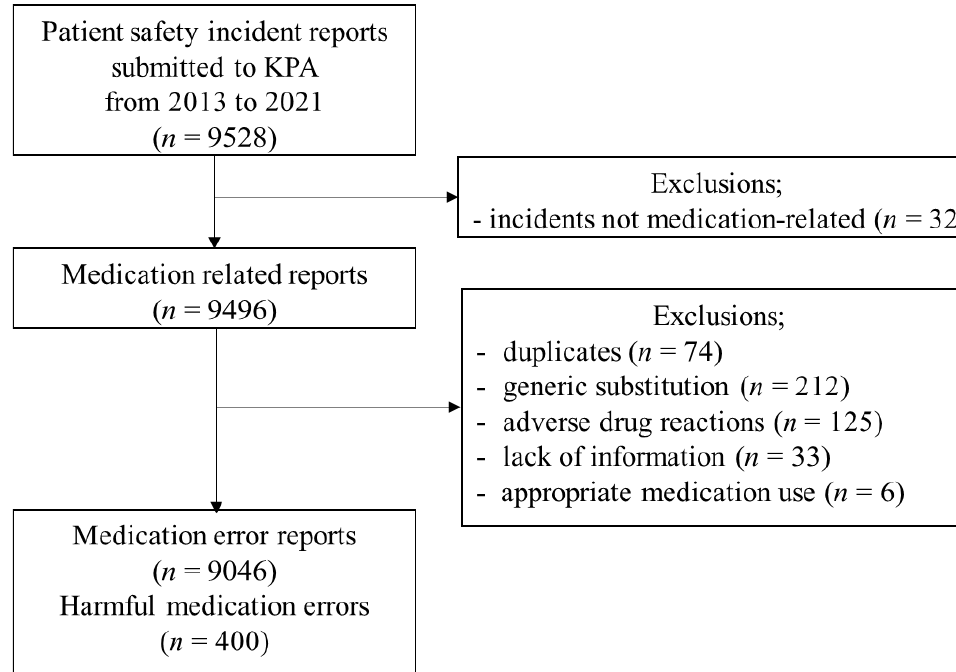
Figure 1. Medication error case selection process. KPA, Korean Pharmaceutical Association.